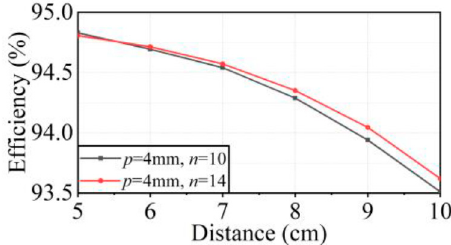
Figure 14. PTE curves with different coil parameters.